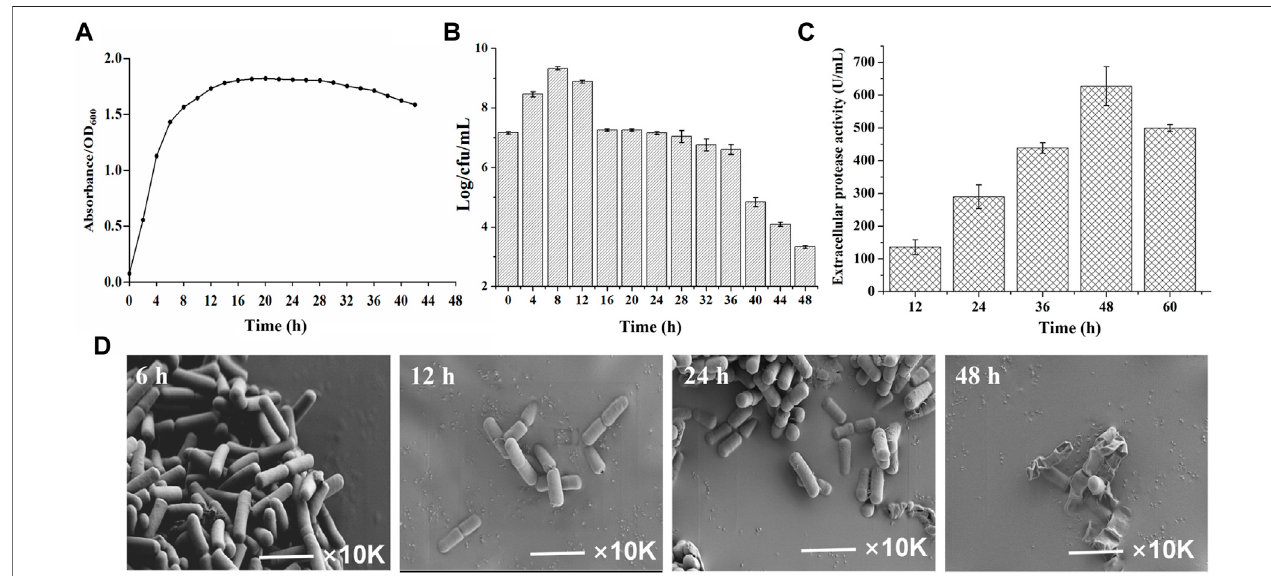
FIGURE2| Thebackgroundintroductionoftheinitialstrain B.amyloliquefaciens TCCC11018. (A) Thegrowthpro fi lesofthe B.amyloliquefaciens TCCC11018wild type(WT)weremeasuredbyculturinginLBmediumafteruniformstartingOD 600 valuesat0 – 44 h.DataarepresentedasmeanvaluesSD. n =3biologicallyindependent samples. (B) Theviablecountsofthe B.amyloliquefaciens TCCC11018wasmeasuredbyculturinginLBmediumat0 – 48 h.DataarepresentedasmeanvaluesSD. n = 3 biologically independent samples. Log/cfu/mL, colony-forming number. (C) The extracellular proteolytic activity of B. amyloliquefaciens TCCC11018. Data are presented as mean values SD. n = 3 biologically independent samples. (D) Cell morphology determination by using the fi eld emission scanning electron microscopy (FESEM) (×10,000) of the B. amyloliquefaciens TCCC11018 by culturing in LB medium, at 6, 12, 24 and 48 h,